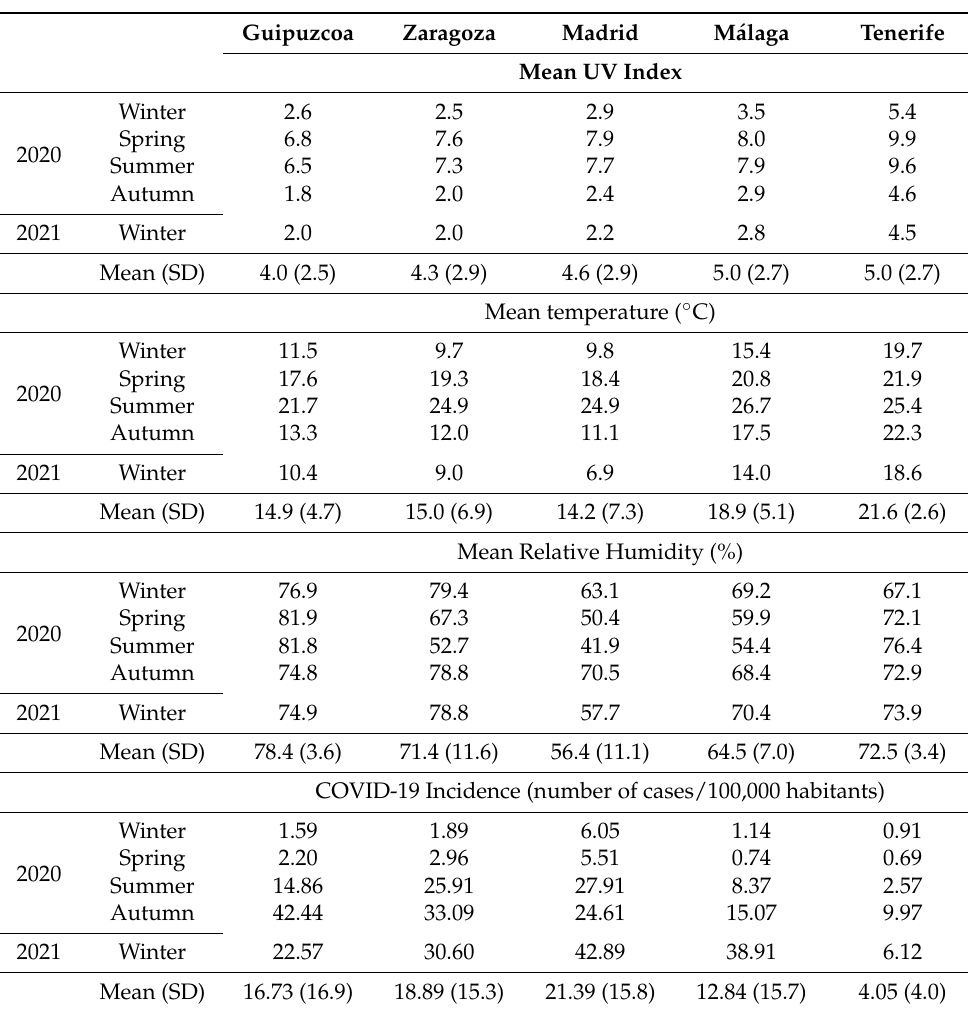
Table 1. Mean UVI, temperature, and humidity per season in the five studied provinces, with the incidence of COVID-19 variables from winter 2020 to the end of winter 2021. Global mean data followed by SD are shown for each variable and localization. Guipuzcoa Zaragoza Madrid M á laga Tenerife Mean UV